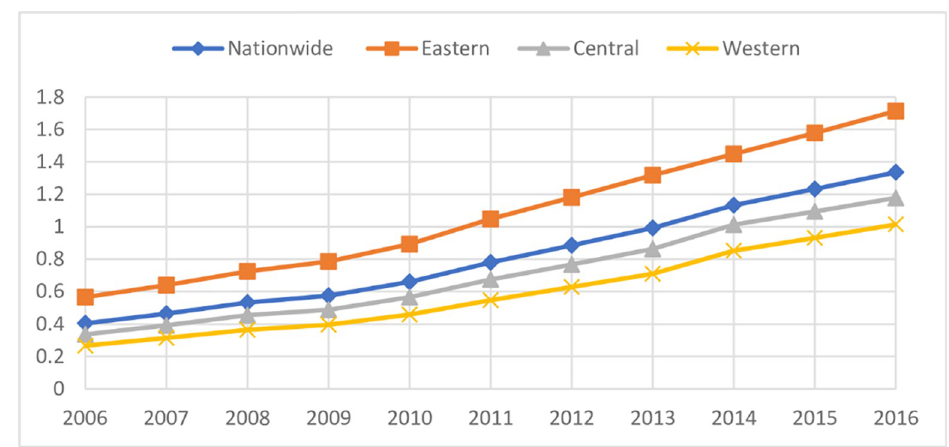
Fig 1. Time trend of farmers’ income of 28 provinces.